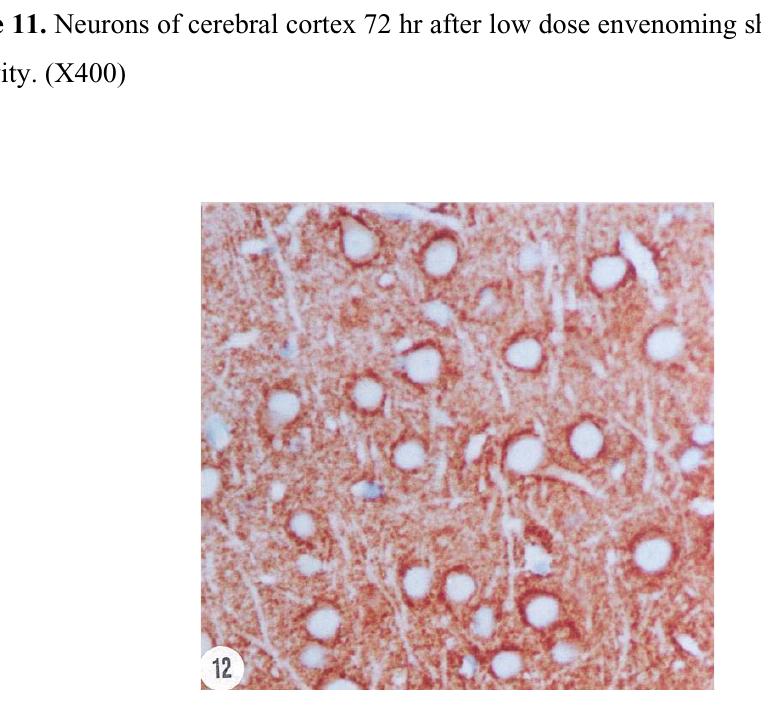
Figure 12. High SYN immunoreactivity 24 hr after high dose envenoming.